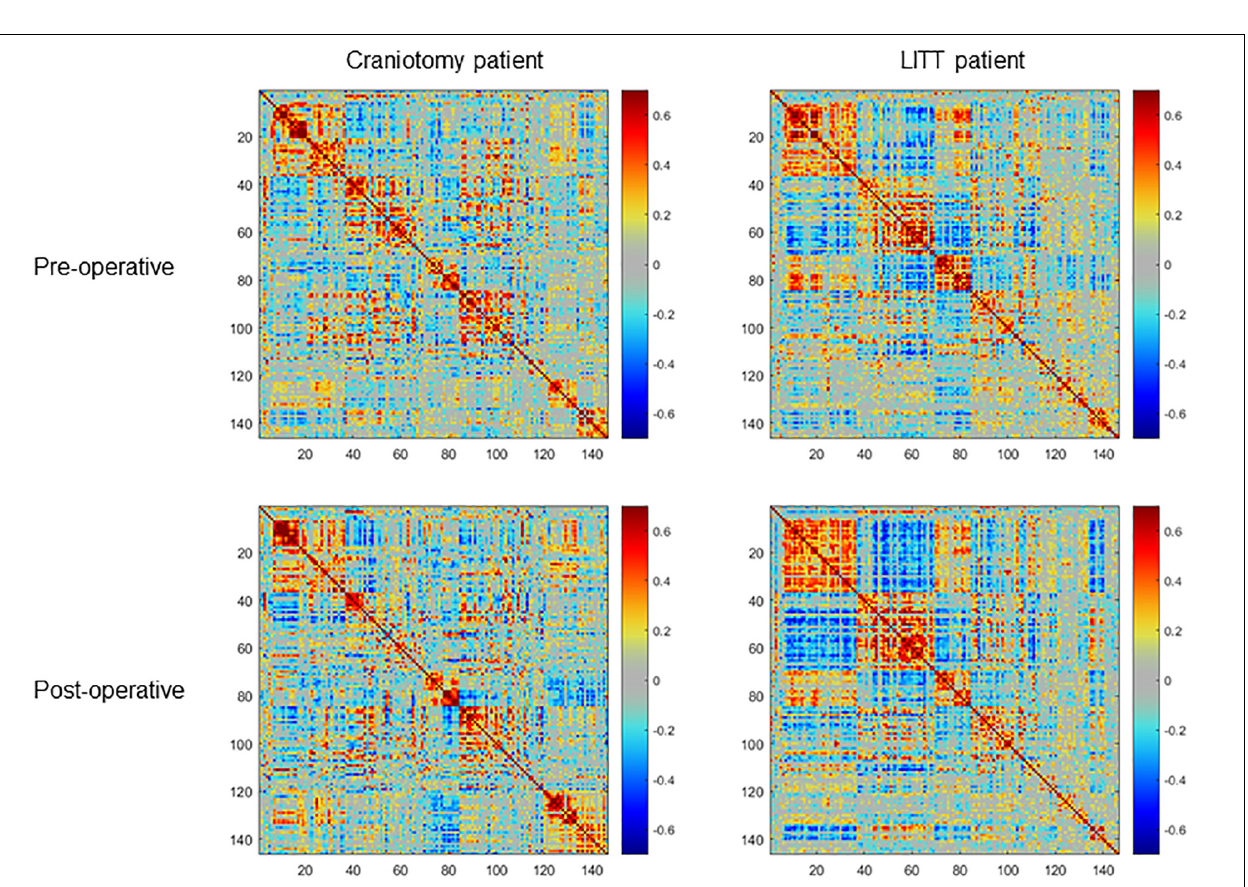
FIGURE 4 | Examples of pre-operative and post-operative within-hemisphere correlation matrices of the contralesional hemisphere (ROIs (regions of interest) = 150) of a single craniotomy patient (left) and a single LITT (laser interstitial thermal therapy) patient (right). The LITT patient had a greater degree of correlation between the pre-operative and post-operative matrices than did the craniotomy patient as determined by the 2-dimensional correlation coefficient.